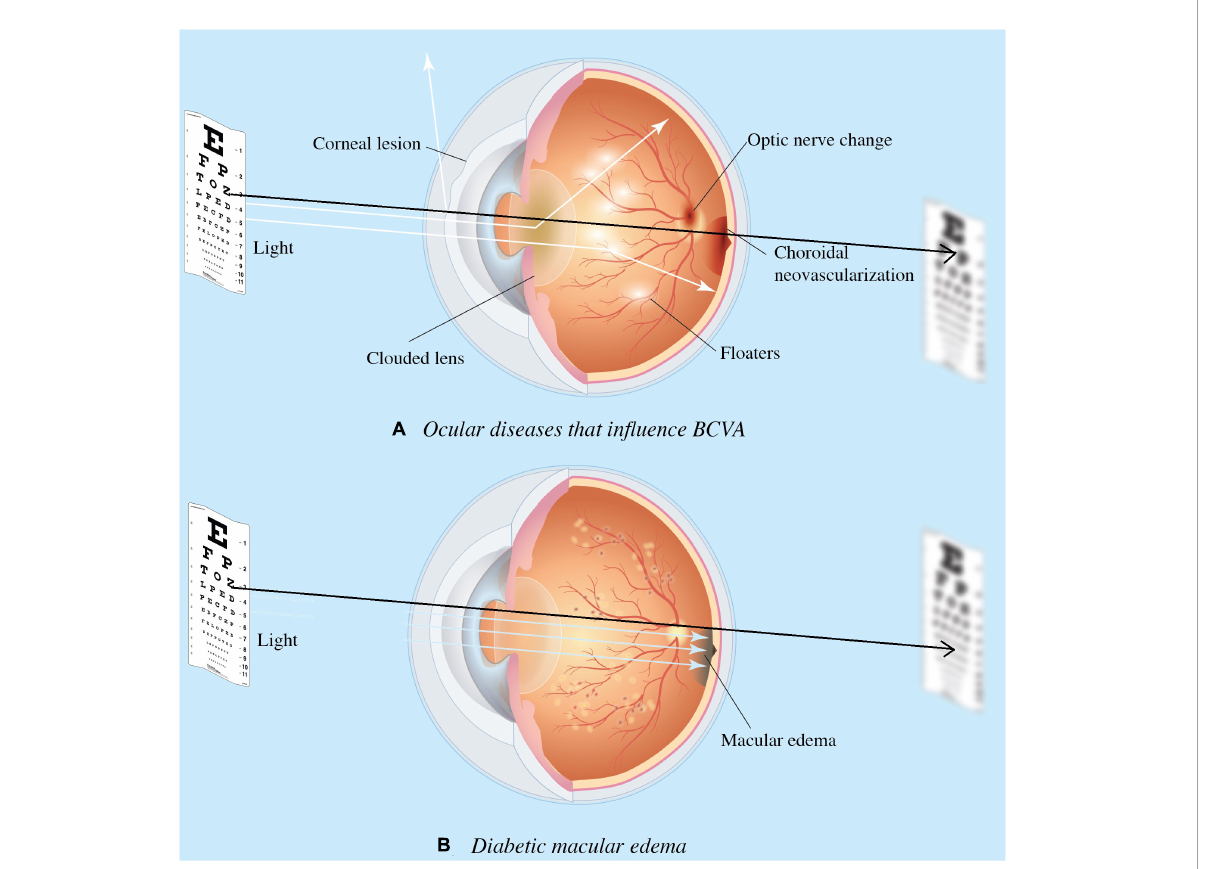
FIGURE1 Ocular diseases that influence visual acuity (VA). Diseases impact the visual axis, such as corneal lesions caused by degeneration, clouded lens by cataract, floaters by uveitis, choroidal neovascularization due to age-related macular degeneration (AMD); and optic nerve neuropathy by glaucoma. Such impact obscures diabetic macular edema’s (DME) involvement in the functional outcome of treatment response, and the need for DME treatment. Diagram (A) presents concurrent ocular disorders that impact VA measurement, while (B) demonstrates the VA directly measures macular health when isolate DME is present. Black arrow denotes the visual